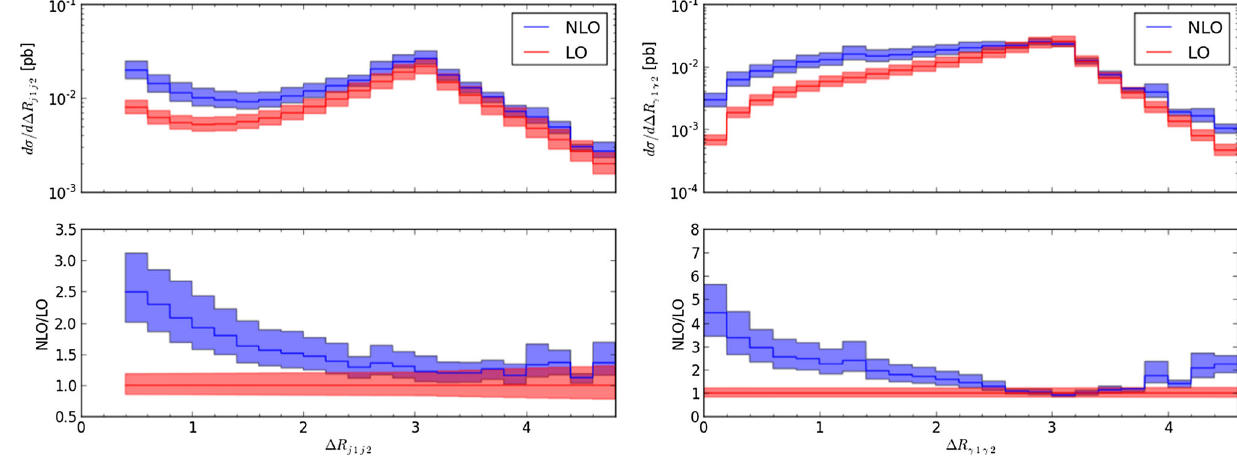
Fig. 5 R -separation of the two leading jets (l.h.s.) and the two photons